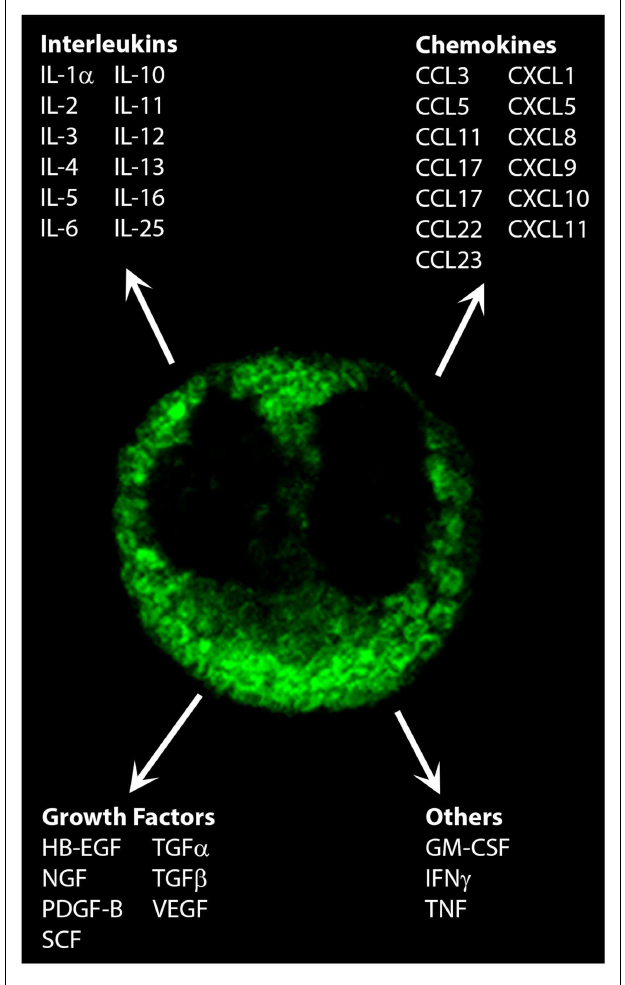
FIGURE 1 | Cytokines, chemokines, and growth factors secreted by eosinophils . Shown is the immunofluorescent staining pattern obtained for CCL5/RANTES in a human peripheral blood eosinophil by confocal microscopy. Original magnification ×